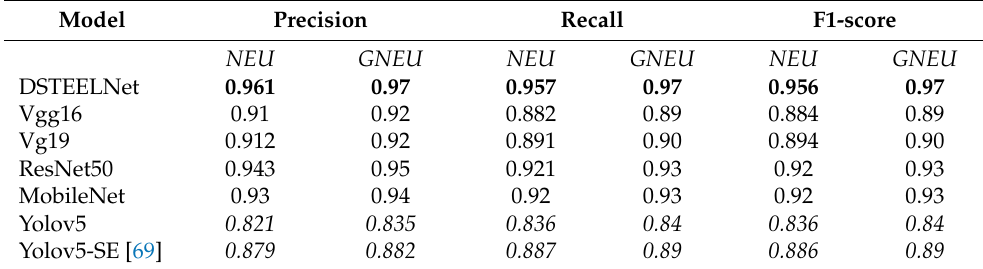
Table 2. Weighted average results on NEU and GNEU datasets.